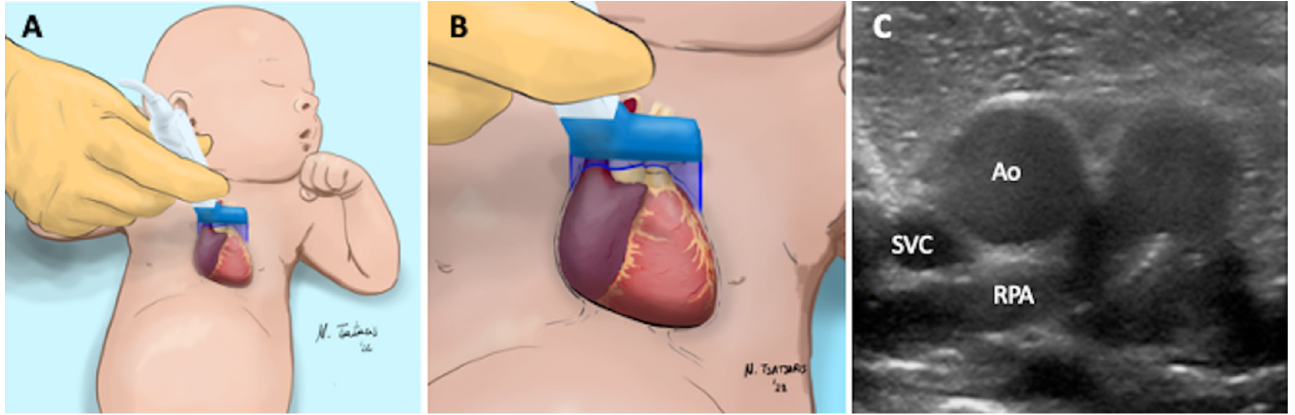
Figure 4. Axial or short axis view of the SVC. ( A ) The high frequency linear probe is placed near the left sternal edge (second intercostal space). ( B ) The ultrasound beam is perpendicular to SVC at the level of the right pulmonary artery. ( C ) The following structures are visualized: superior vena cava (SVC), aorta (Ao), right pulmonary artery (RPA).